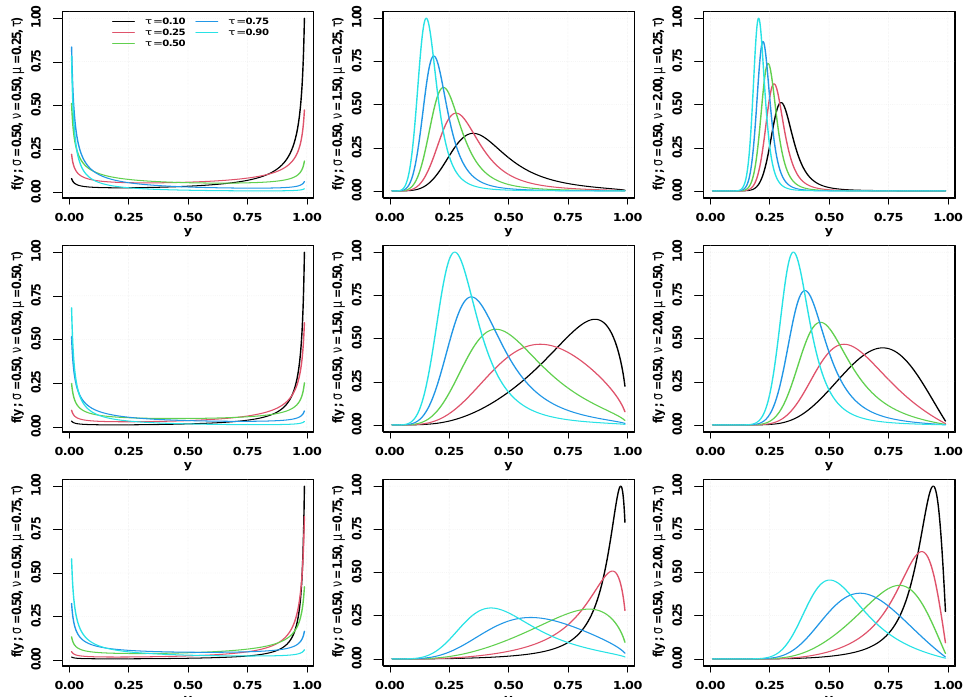
Figure 2. Plots of the UWMOQ PDF for the indicated values of µ , ν , τ , and σ = ς = 0.5.